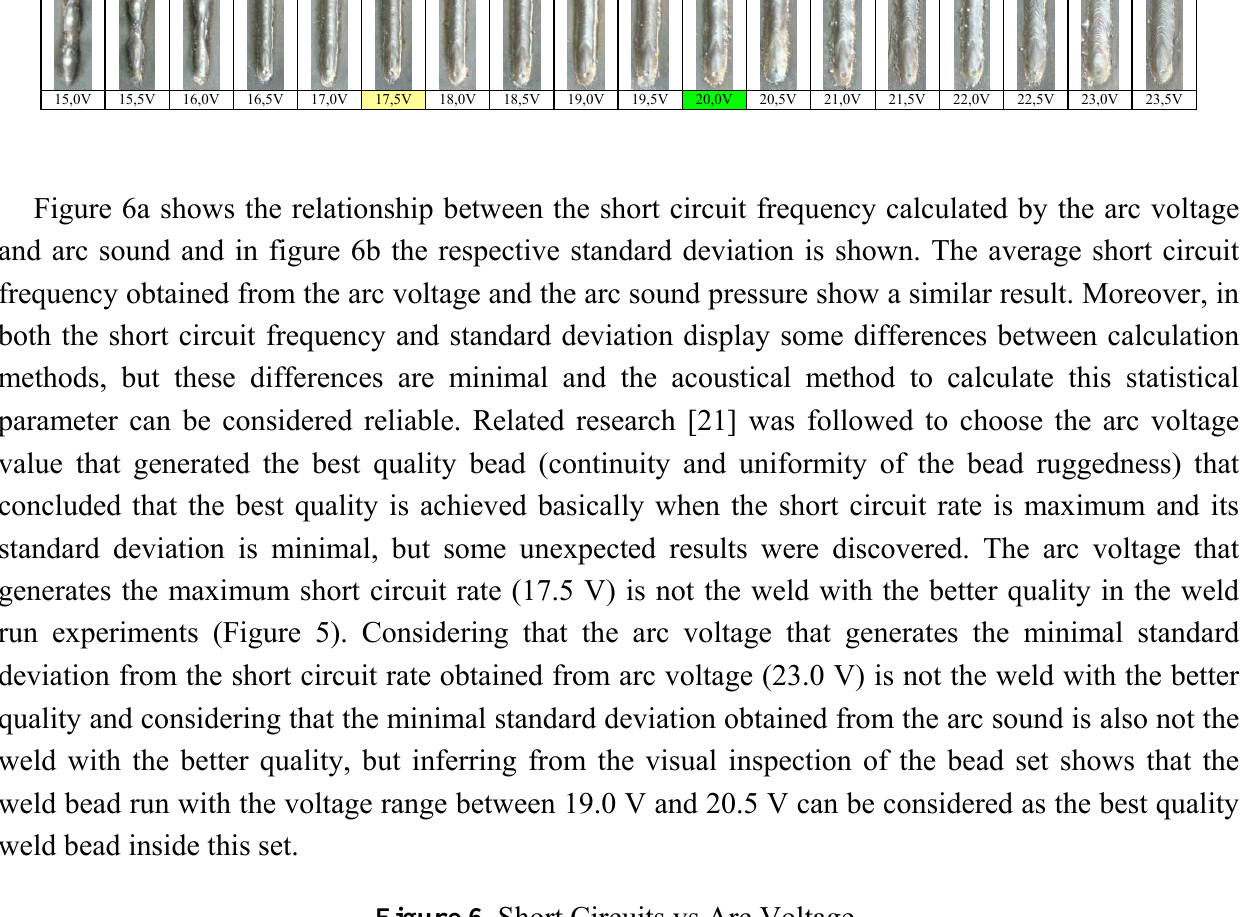
Figure 6. Short Circuits vs Arc